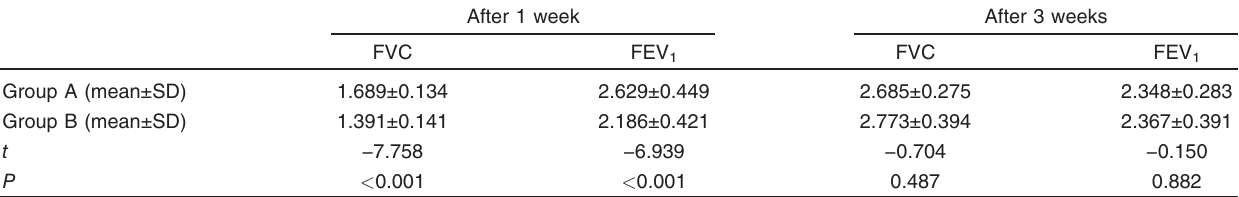
Table 5 Comparison of spirometric values in both groups after 1 and 3 weeks